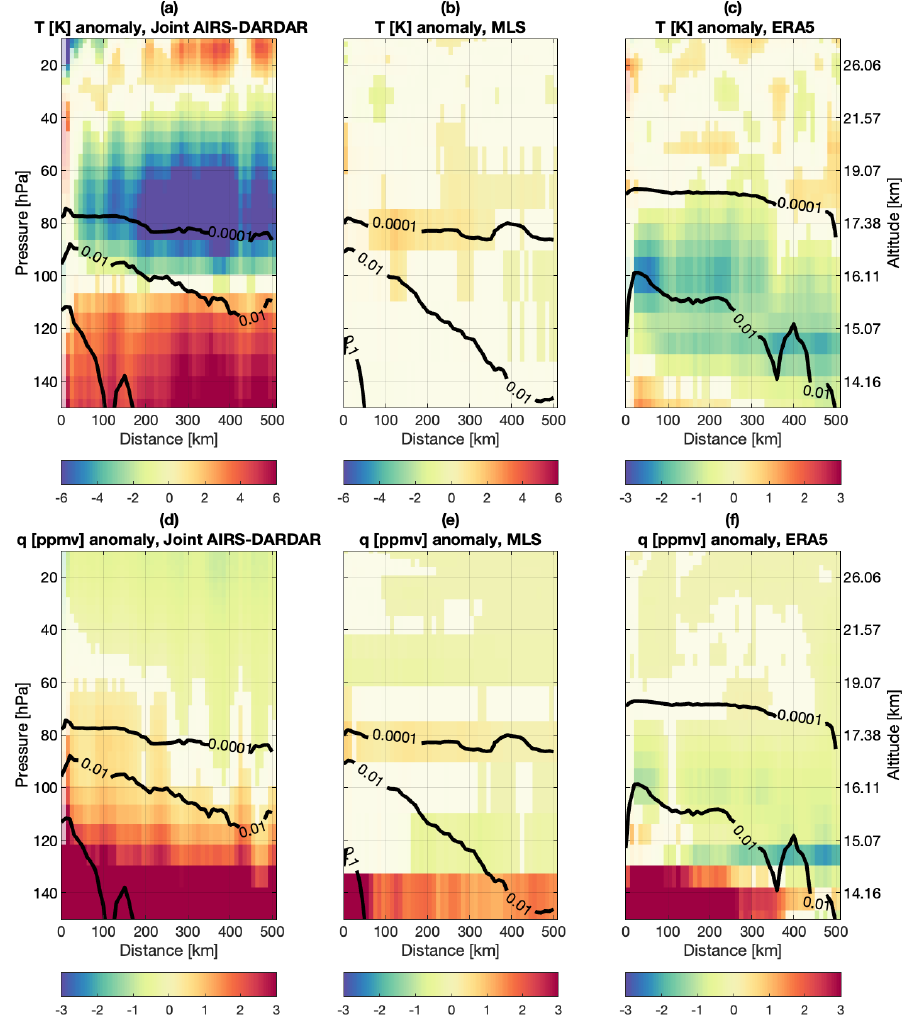
Figure 8. Cyclone-centered composites of temperature (shading, K), water vapor anomalies (shading, ppmv), and ice water content (black contour, g/m 3 ). Anomalies below the 99% confidence level are set to be transparent. (a, d) Similar to Fig. 7a and e but after subtracting the climatologies of temperature from the AIRS L2 product and water vapor from the MLS v4.2 product, respectively. (b, e) Similar to Fig. 7b and f but after subtracting the climatologies of temperature and water vapor from the MLS v4.2 product. (c, f) Similar to Fig. 7c and g but after subtracting the climatologies of temperature and water vapor from